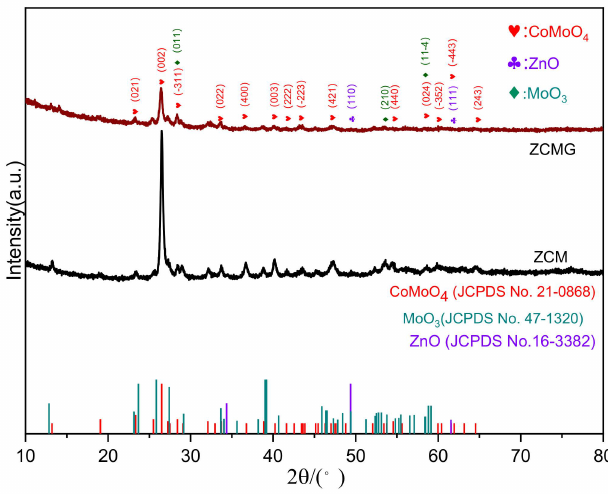
Figure 2. XRD patterns of ZCM and ZCMG.